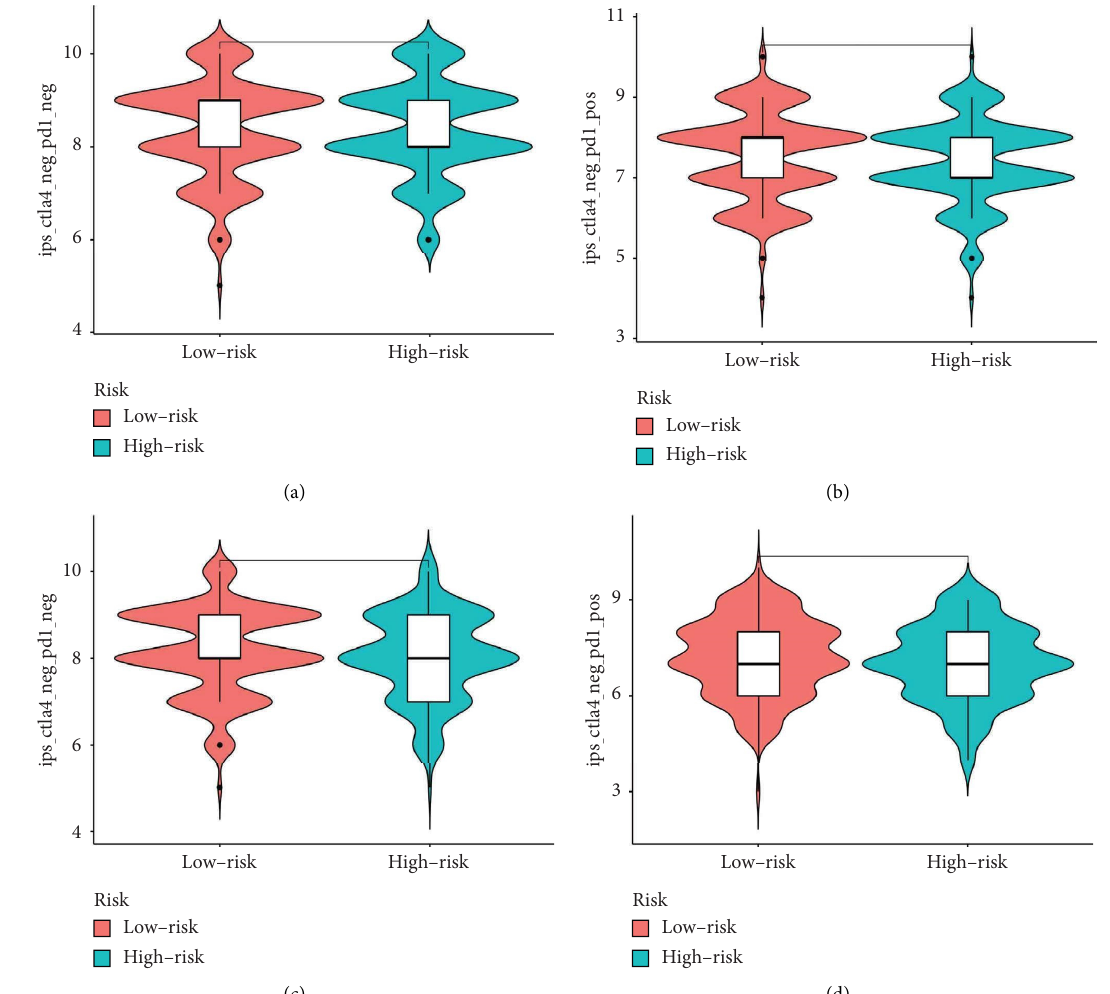
Figure 6: (a) Immunotherapy evaluation of CTLA4 negative and PD1 negative patients between low- and high-risk groups. (b) Im- munotherapy evaluation of CTLA4 negative and PD1 positive patients between low-and high-risk groups. (c) Immunotherapy evaluation of CTLA4 positive and PD1 negative patients between low- and high-risk groups. (d) Immunotherapy evaluation of CTLA4 positive and PD1 positive patients between low-and high-risk